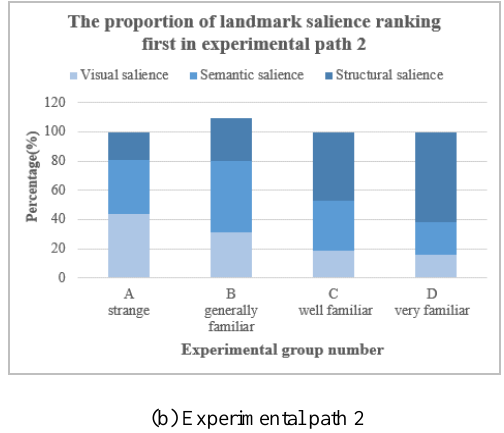
Figure 7. The proportion of landmark salience ranking first in the hand-painted sketches painted by subjects